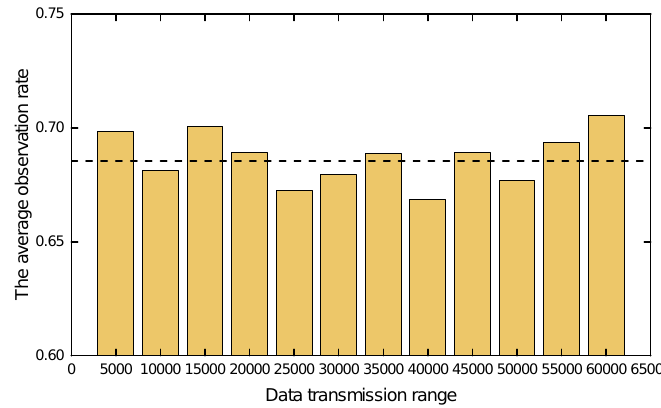
Figure 8. The impact of different communication conditions on search performance under the condition of N / M = 20/40 and SR = 2600 units.